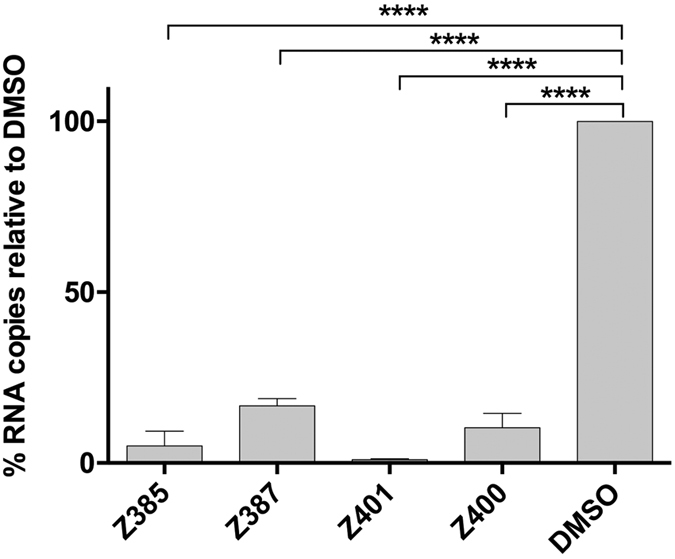
Huh7 cells were infected with TCP expressing N17 SGR-luc and exposed to the compounds for 24 h.Results were obtained measuring luciferase expression from cell lysates. One-way ANOVA Test (****p < 0.0001).